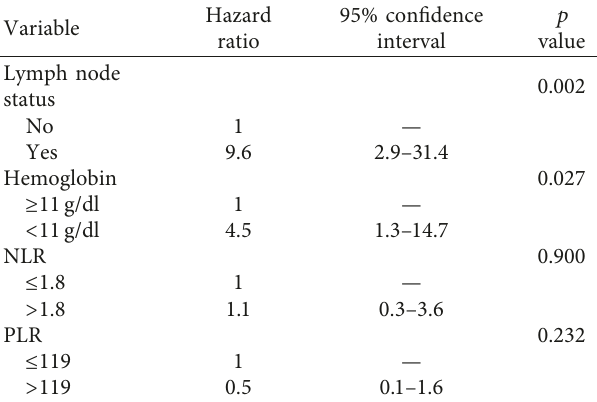
Table 5: Multivariate analysis of overall